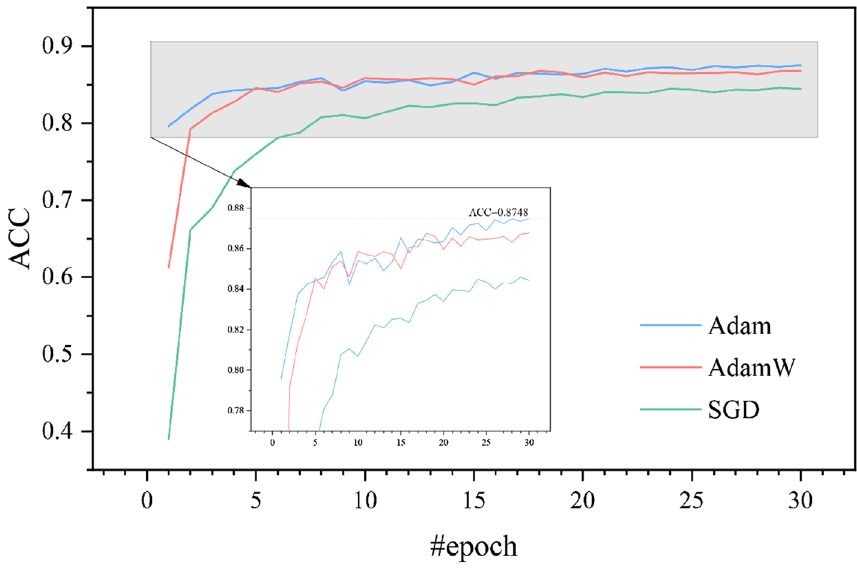
Fig. 10 Accuracy comparison of different optimizers with dropout